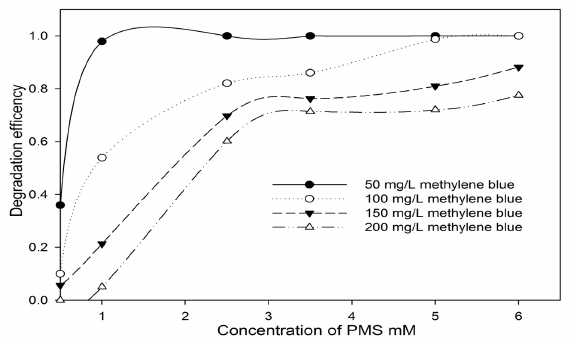
Figure 3: Degradation of different concentrations of methylene blue using PMS at different concentrations for 24